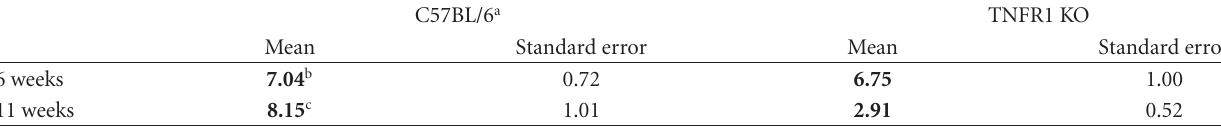
Table 2: Quantification of apoptosis at the site of infection by L. major in WT and TNFR1 KO mice.